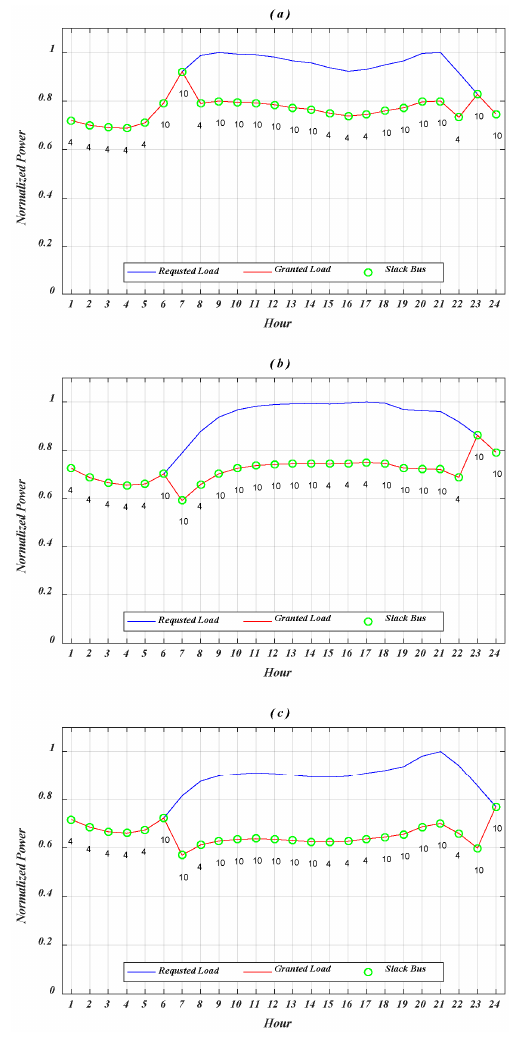
Figure 6. Normalized requested demand, and the power granted for 24 h when MGs located at L3 for: ( a ) Area 1; ( b ) Area 2; and ( c ) Area 3.